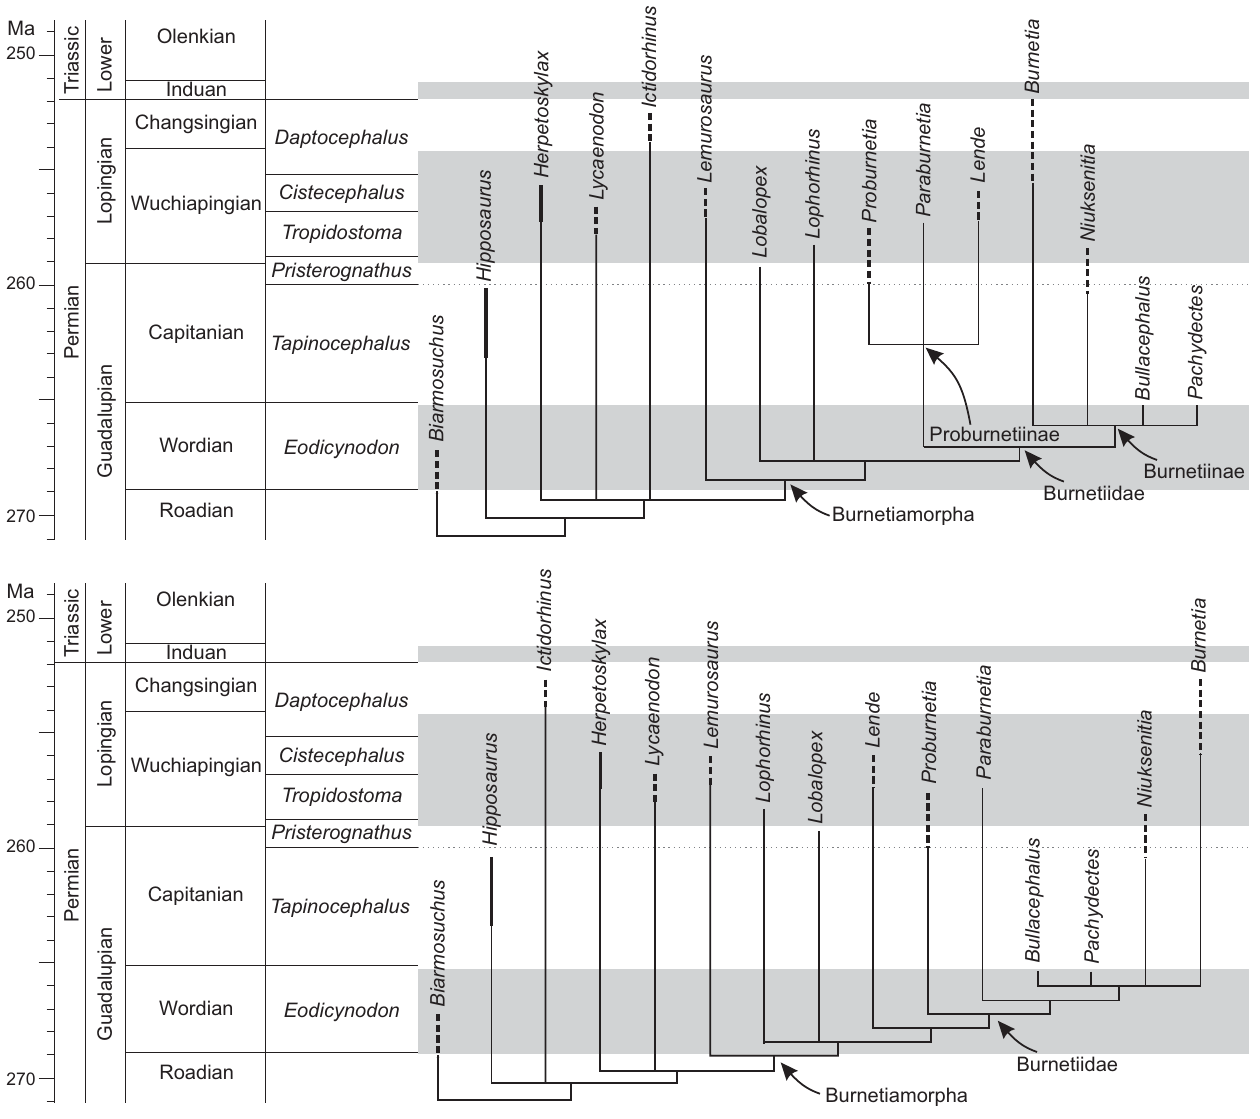
Fig. 7. Previous phylogenies for the Biarmosuchia scaled to time and plotted against Permian Beaufort biostratigraphy. A . The strict-consensus tree of Kammerer (2016). B . The majority-consensus tree of Kruger et al. (2015). Dotted line indicates the Capitanian extinction horizon as recorded in South